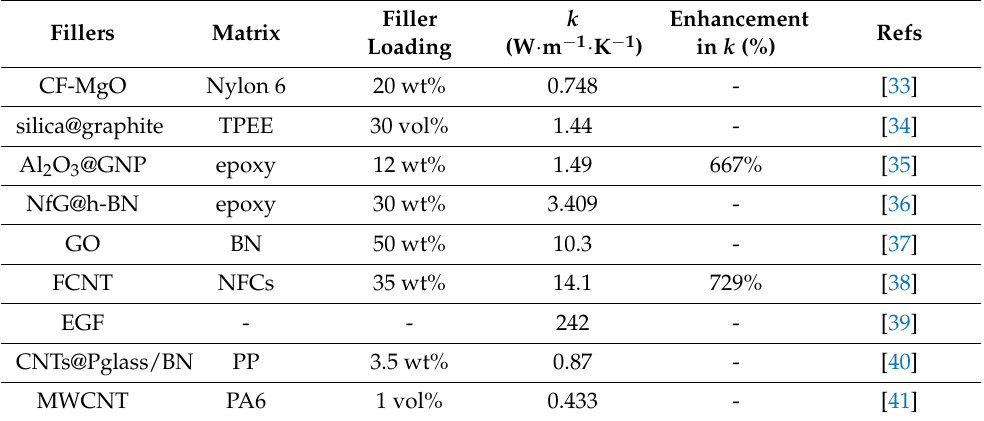
Table 2. Thermal conductivity ( k ) values of various polymer composites with electrically insulating carbon